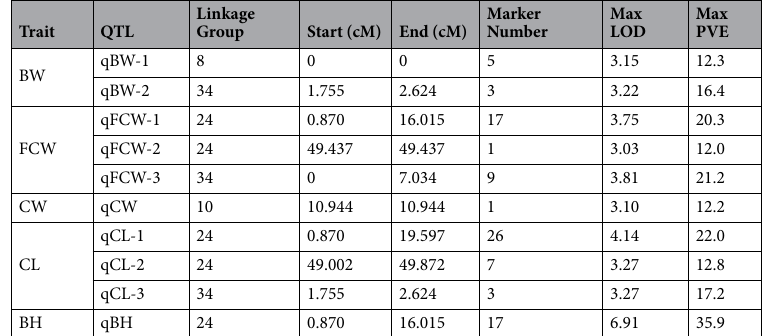
Table 6. Characteristics of growth related